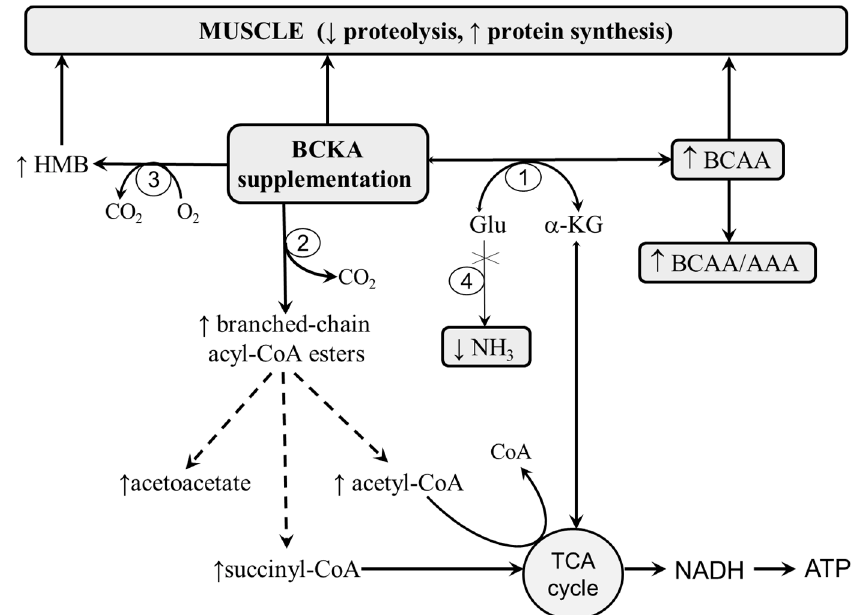
Figure 3. Supposed effects of BCKA supplementation on (i) the formation of BCAAs, (ii) diversion of glutamate from breakdown to ammonia to the BCAA and α -KG synthesis, (iii) protein balance, and (iv) the TCA cycle (anaplerosis). 1, branched-chain aminotransferase; 2, BCKA dehydrogenase; 3, ketoisocaproate (KIC) dioxygenase; 4, glutamate dehydrogenase.